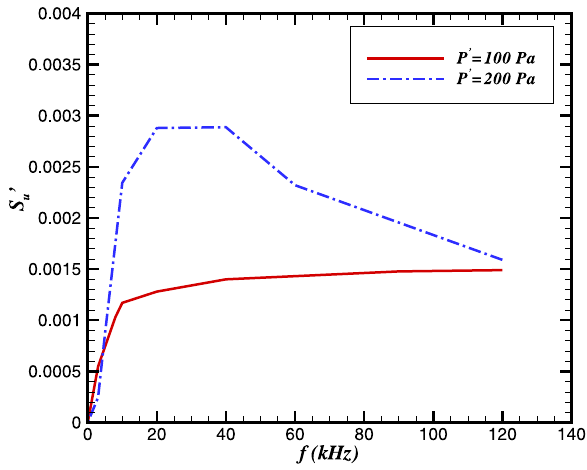
Figure 19. Relative change in the burning velocity vs frequen- cy.